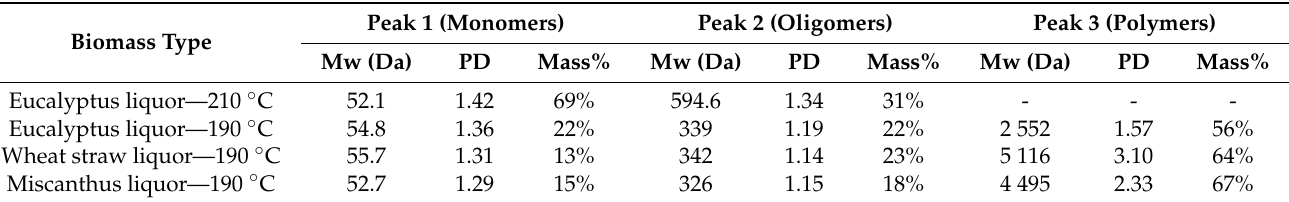
Table 2. Data of SEC